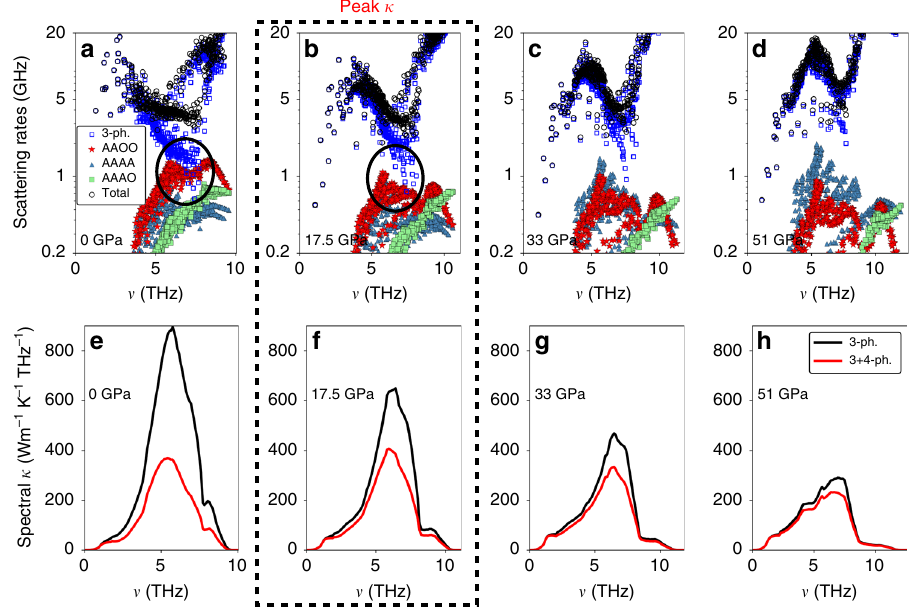
Fig. 3 Opposing responses of three- and four-phonon scattering strengths to pressure. a – d Total three-phonon and process-wise four-phonon scattering rates of the acoustic phonons in BAs as a function of the phonon frequency ( ν ) at 300 K and at different pressures. As pressure increases, total three- phonon scattering rates and AAAA four-phonon scattering rates strengthen, but AAAO and AAOO four-phonon scattering rates weaken. The competing responses to increasing pressure from three-phonon processes and the dominant AAOO four-phonon processes below 20 GPa cause a thermal conductivity peak at ~17.5 GPa (shown by the dashed box). Beyond 50 GPa, three-phonon scattering completely dominates over four-phonon processes; thus the strengthening AAAA four-phonon scattering rates have a very weak effect on the pressure dependence of κ (3 + 4) . The oval regions in a and b show the frequency range that contributes the most to the κ of BAs. e – h Spectral contributions to κ (3) and κ (3 + 4) as a function of ν at different pressures for acoustic phonons. The frequency range of 4 – 8 THz produces the largest contribution to both κ (3) and κ (3 +